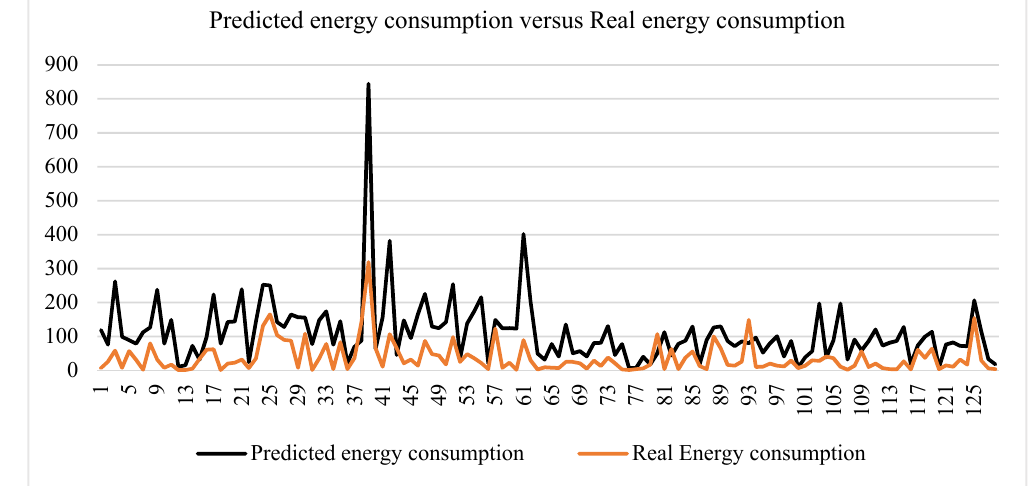
Figure 13. Predicted energy consumption versus Real energy consumption.